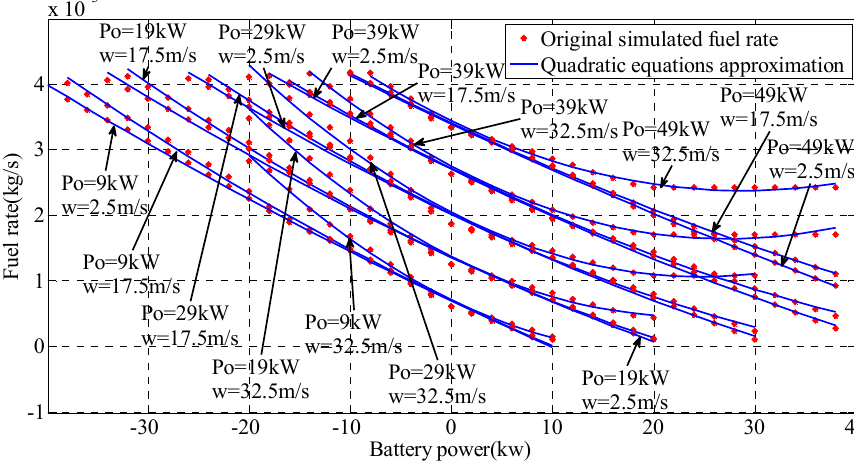
Figure 5. Fuel-rate validation and approximation.